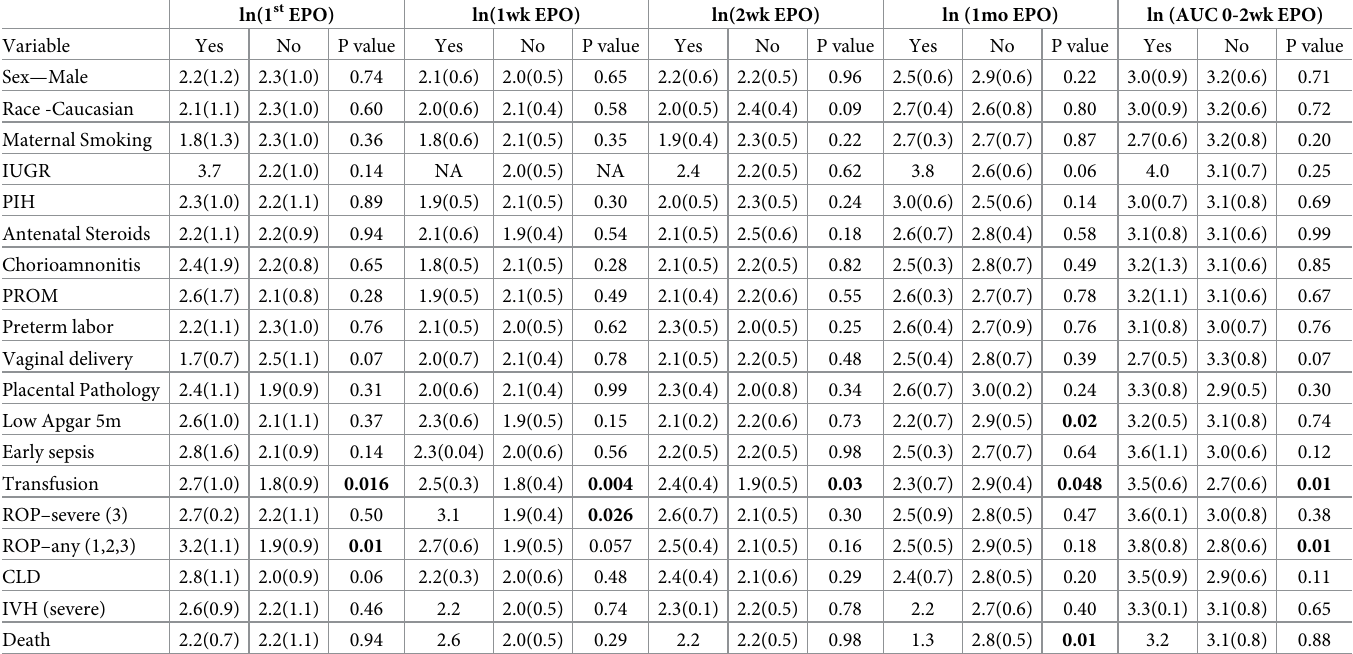
Table 4. Association between ln[EPO] and binary risk factors, outcomes, and